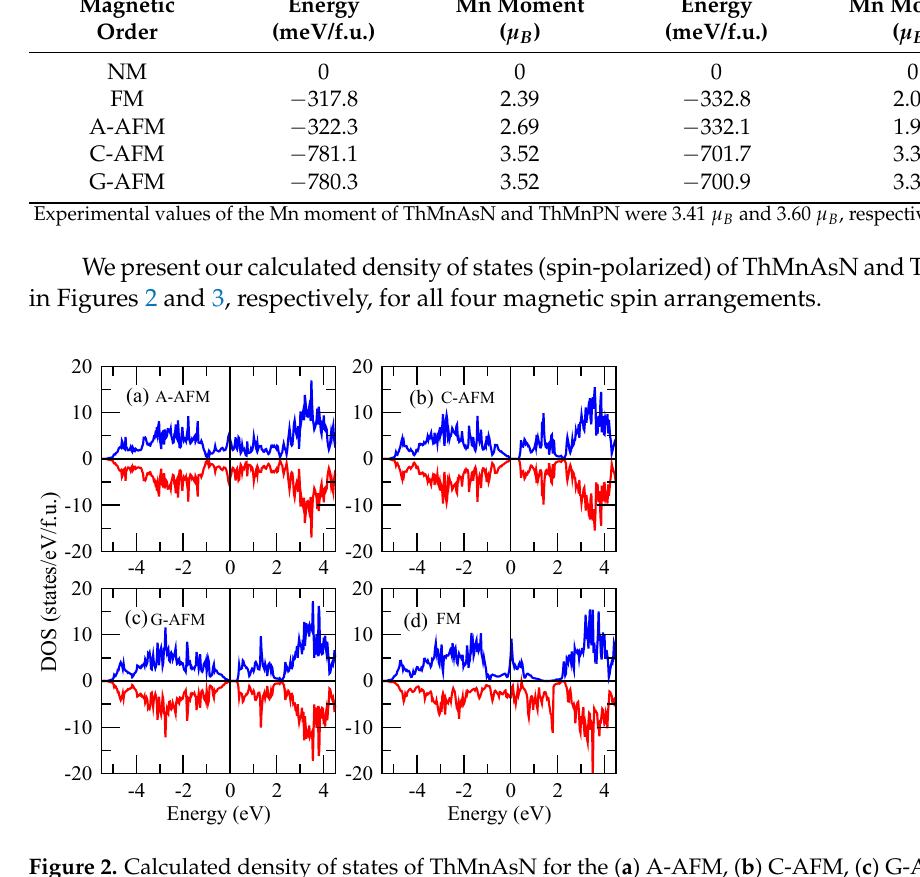
Table 1. Calculated total energies (with respect to the NM state) and local magnetic moments of the Mn atoms of ThMnXN (X = As, P) with the experimental structure (at 4 K) for the NM, FM, A-AFM, C-AFM, and G-AFM states. The energy of the NM state was set to zero. ThMnAsN ThMnPN Magnetic Energy Mn Moment Energy Mn Moment Order (meV/f.u.) ( µ B ) (meV/f.u.) ( µ B ) NM 0 0 0 0 FM − 317.8 2.39 − 332.8 2.03 A-AFM − 322.3